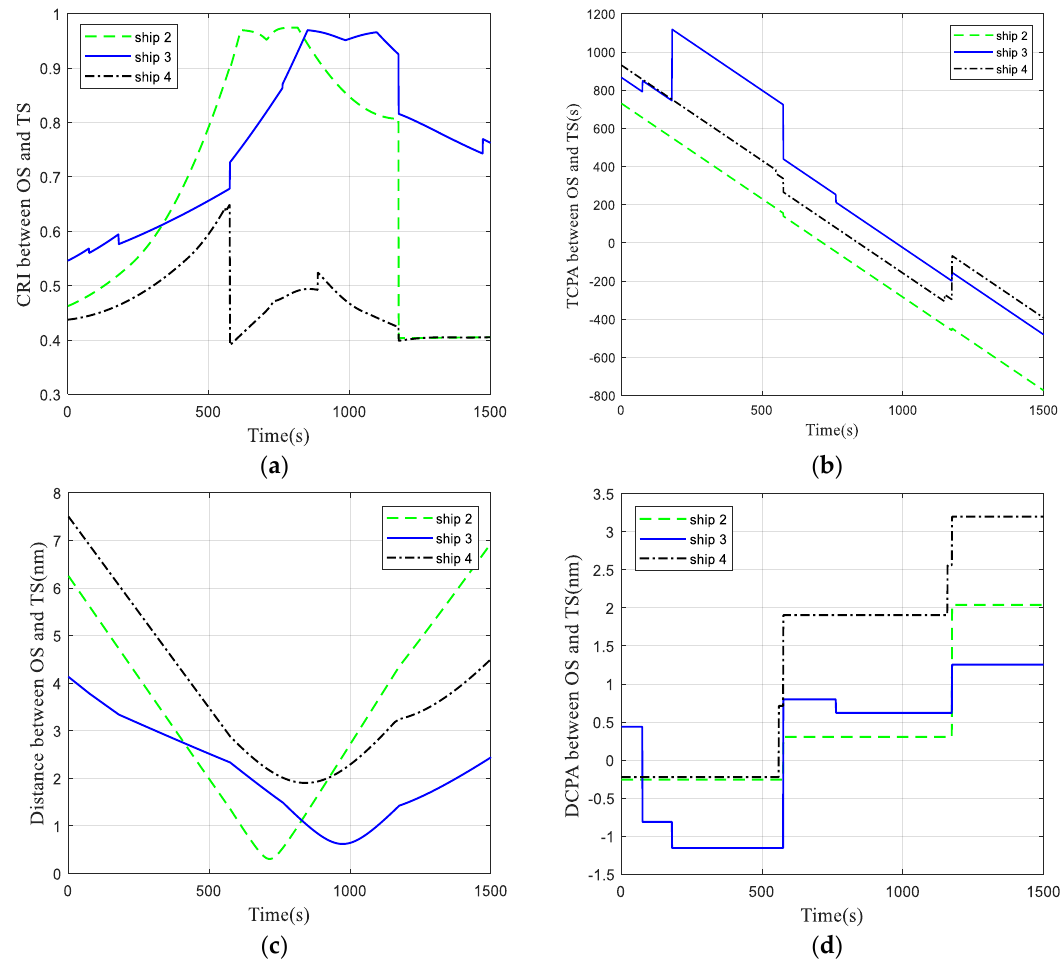
Figure 14. Real-time parameter changes under scenario 5: ( a ) the collision risk index ( CRI ) with the Target Ships (TSs), ( b ) the time to the closest point of approach ( TCPA ) with the TSs, ( c ) the relative distance with the TSs and ( d ) the distance to the closest point of approach ( DCPA ) with the TSs. Table 6. Actions taken by each ship in scenario 5.